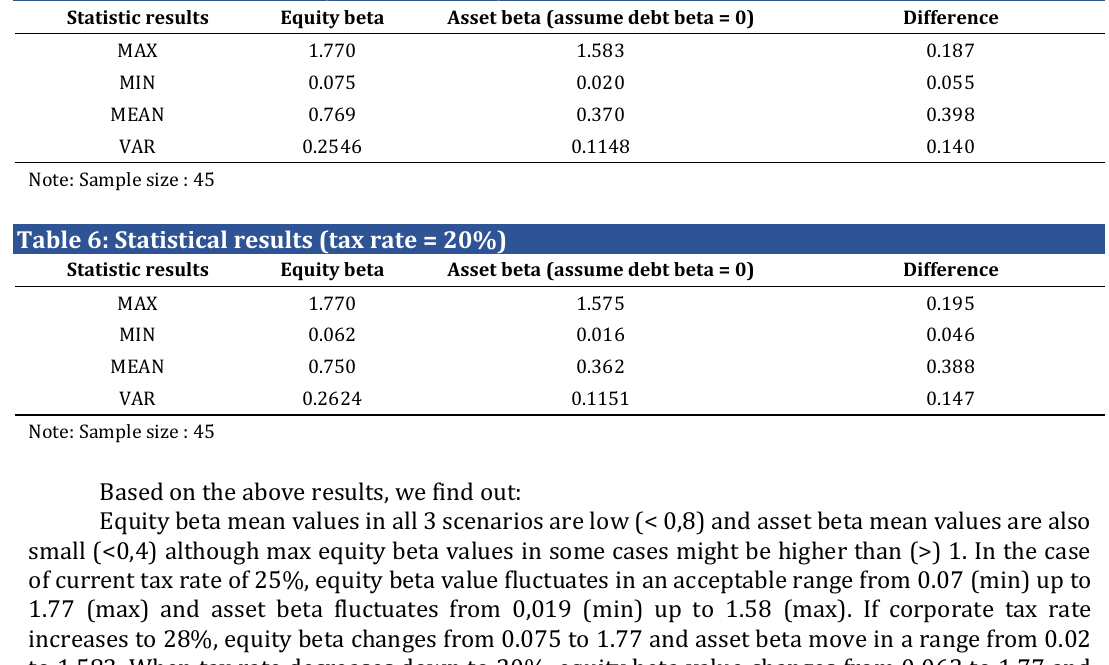
Table 5: Statistical results (tax rate = 28%)